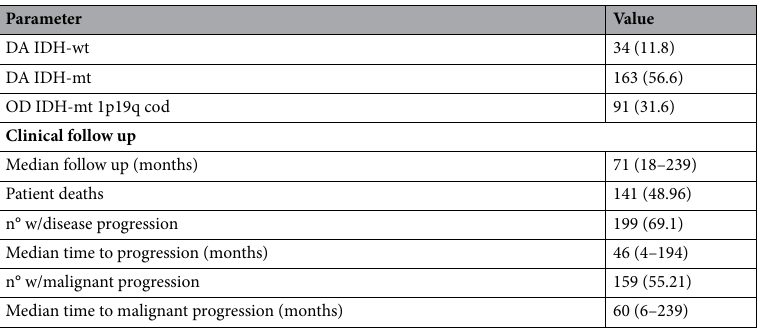
Table 1. Clinical, radiological and molecular characteristics of the study population. Characteristics of the study population are described using means (standard deviation) or median and range for continuous variables, number of cases with relative percentages reported in parentheses for categorical variables. ΔT2T1 MRI index volumetric difference between preoperative tumor volumes on T2 and T1 weighted MRI images, EOR extent of surgical resection, DA IDHwt Diffuse Astrocytoma Isocitrate Dehydrogenase wild type, DA IDHmt Diffuse Astrocytoma Isocitrate Dehydrogenase mutated, OD IDHmt 1p19q cod Oligodendroglioma Isocitrate Dehydrogenase mutated, 1p 19q codeleted.